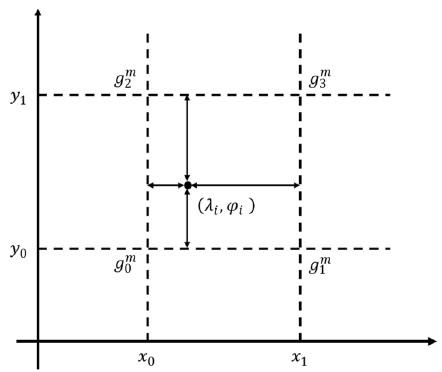
Figure 1. Bilinear interpolation method.